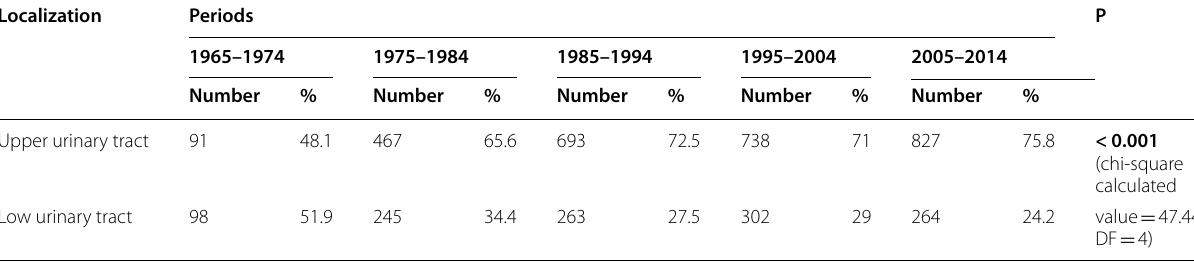
Table 4 Comparison of the general localization of lithiasis between 1965 and 2014 by decade Localization